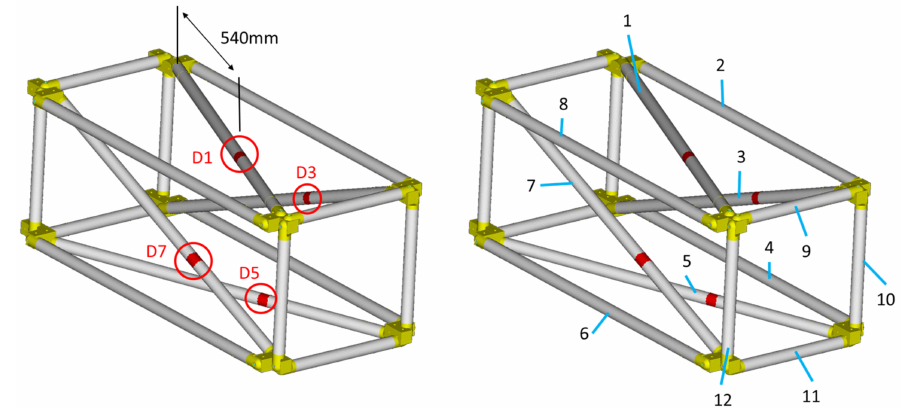
Figure 8. Damage cases ( left ). CFRP tube identification numbers ( right ).